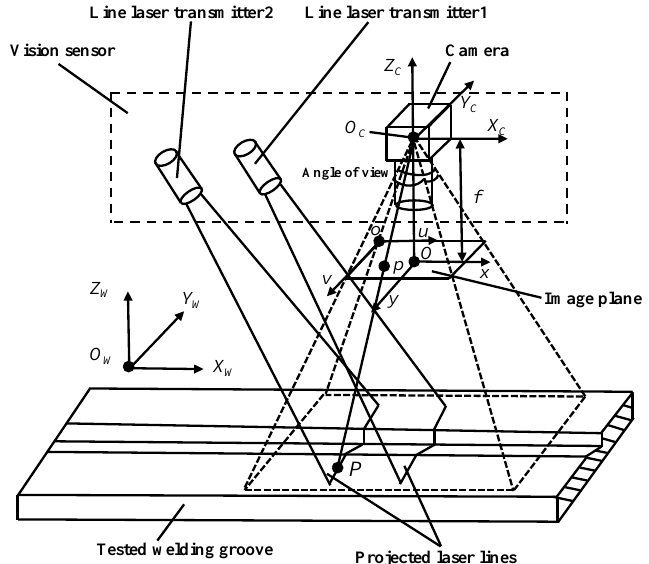
Figure 2. Schematic diagram of working principle of vision sensor.